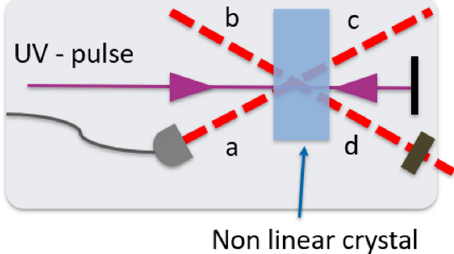
FIG. 11. Schematization of parametric down-conversion — interaction between a UV pulse beam with a nonlinear crystal (BBO).